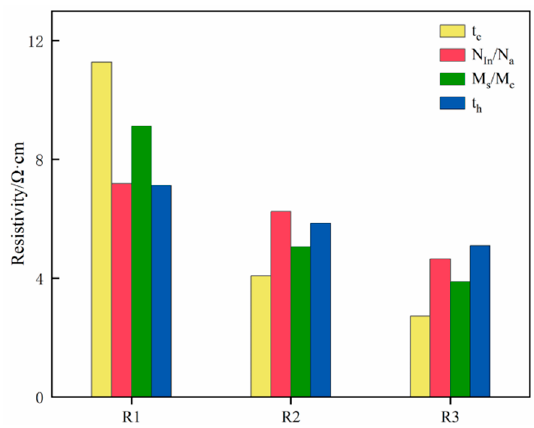
Figure 2. The effect of a single factor on the resistivity.